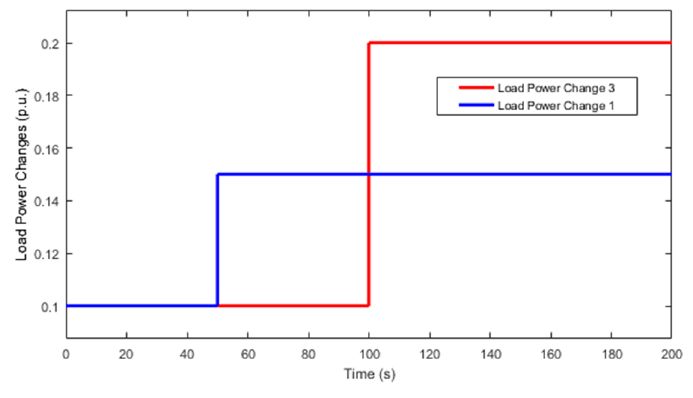
Figure 10. Load power changes of microgrids 1 and 3.